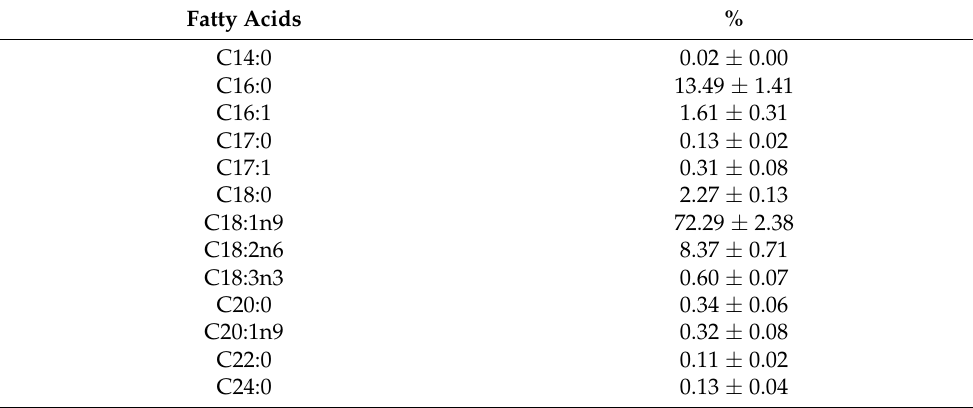
Table 4. Fatty acids profile (% FAME) of dried destoned virgin olive pomace (DDVOP). The data represent the mean values of three replications with their relative standard deviation (RSD).